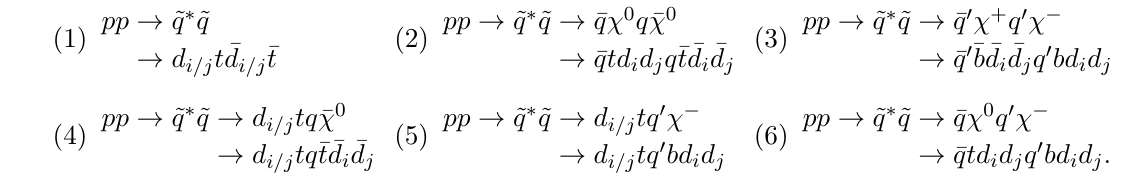
Figure 11. Exclusion plots for a 200 GeV Higgsino-up neutralino LSP with the U(1) R symmetry strictly preserved. The grey region on the left side of the plots ( m ~ dijet searches. Next, consider the middle region of the plots. Starting from large (cid:21) 00 working downwards, the blue region is excluded by dijet searches, the green region is excluded by neutralino LSP searches and the red region is excluded by displaced vertices